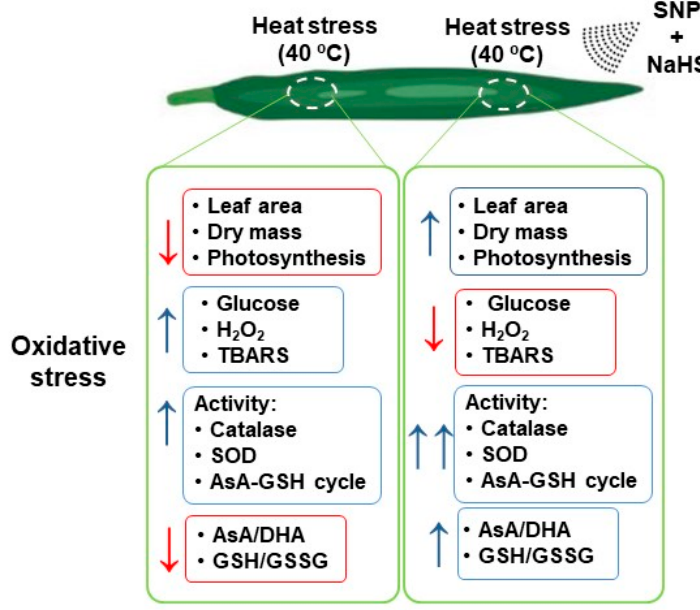
Figure 9. Summary of the main effects of HS (40 °C) in wheat leaf plants untreated or treated exogenously with SNP (100 µM) and NaHS (200 µM) as NO and H 2 S donors, respectively, which palliates the oxidative stress damages.